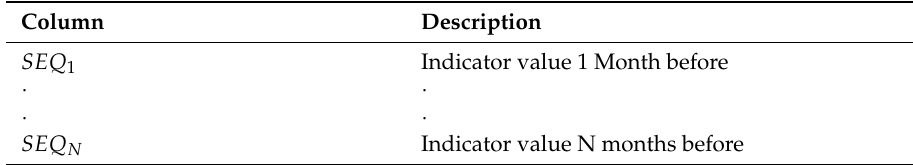
Table 4. Sequence features.